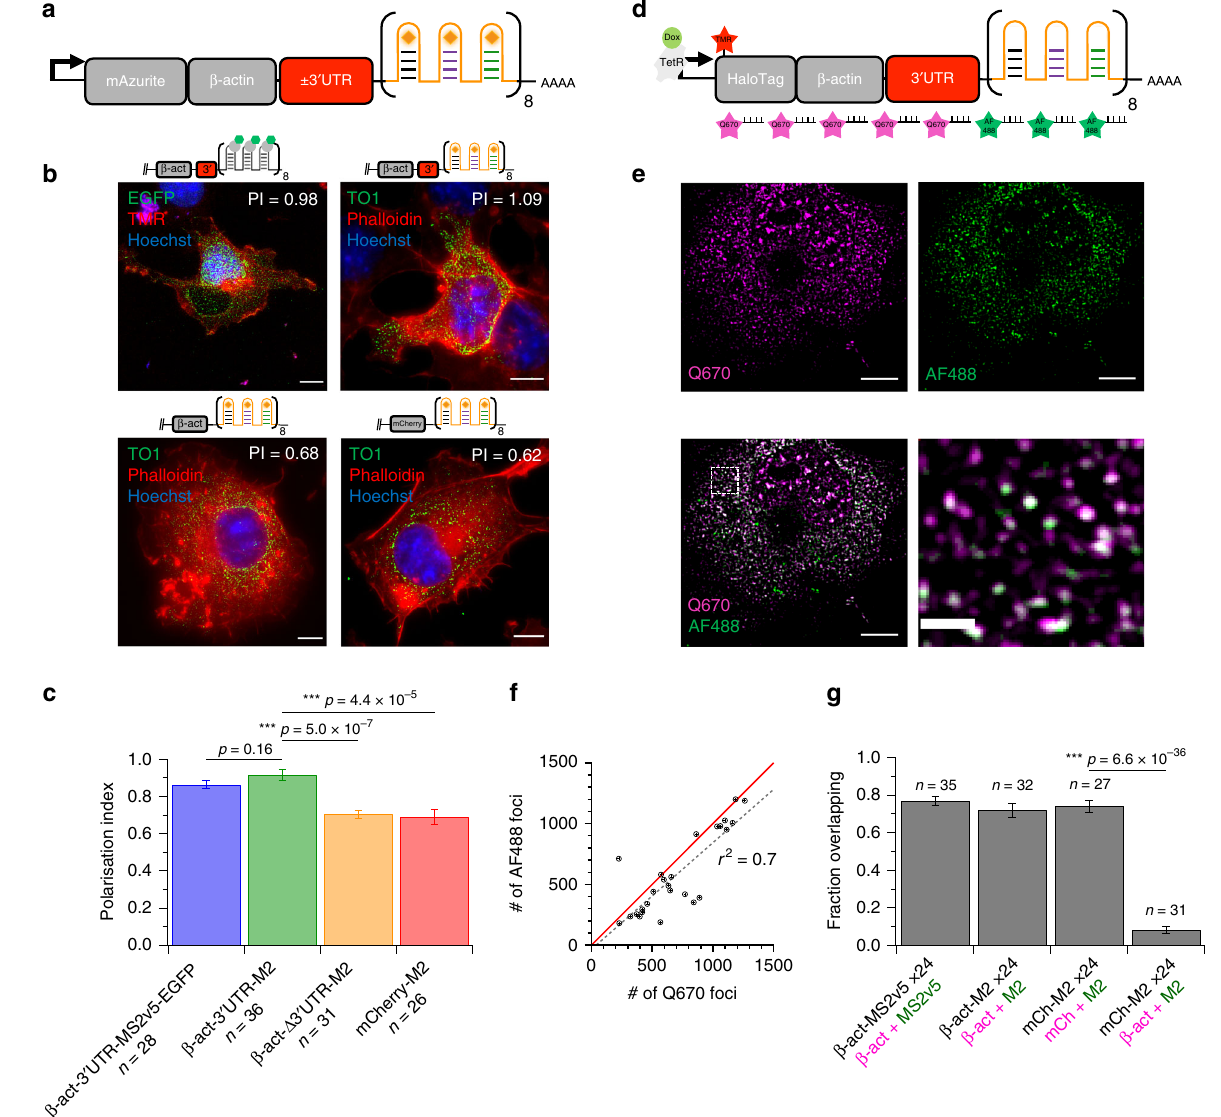
Fig. 4 Imaging polarisation of β -actin mRNAs in fi broblasts. a Diagram of the mAzurite labelled β -actin-± 3 ′ UTR-M2x24 construct under the control of a constitutive promoter. b Representative fi xed cell images of the localisation patterns for the mAzurite- β -actin-3 ’ UTR-MS2v5x24 — EGFP (top left), mAzurite- β -actin-3 ′ UTR-M2x24 (top right) mAzurite- β -actin- Δ 3 ′ UTR-M2x24 (bottom left) and mCherry-M2x24 (bottom right) constructs in Cos-7 cells. Stained with TO1-B (200 nM — green channel), TMR or AlexaFluor ® 647-Phalloidin (165 nM — red channel) and Hoechst 33258 (1 µ g/ml – blue channel), scale bars = 10 µ m. Mean PI calculation for RNA localisation within the depicted cell shown in white inset. c Mean PI for each Mango tagged construct for multiple cells ( n indicated), error bars depict the standard error in the mean and p-values calculated using a two-tailed student ’ s T-test. d Diagram of Quasar ® 670 (Q670 - magenta) and Alexa Fluor ™ 488 (AF488 — green) smFISH probes against the TMR labelled Halo- β -actin-3 ’ UTR-M2x24 construct under the control of a doxycycline inducible promoter. e Maximum projection of a cell expressing Halo- β -actin-3 ’ UTR-M2x24 mRNA and visualised with β - act-Q670 (magenta) and M2-AF488 (green) smFISH probes. Scale bars = 10 µ m and 2 µ m for high magni fi cation image (lower right panel). f Total number of RNA foci in dually labelled Halo- β -actin-3 ′ UTR-M2x24 with smFISH AF488 and Q670 probes using FISH-quant. Single cells foci numbers depicted as grey data points, a line with a gradient = 1 (solid red) and data points fi t with a straight line (dashed black — slope = 0.88, r 2 = 0.7). g Calculated fraction of overlapping signals from multiple dually labelled mRNAs with n as number of cells, error bars depict the standard deviation. RNA construct labelled in black with the corresponding smFISH probes in magenta (Q670) and green